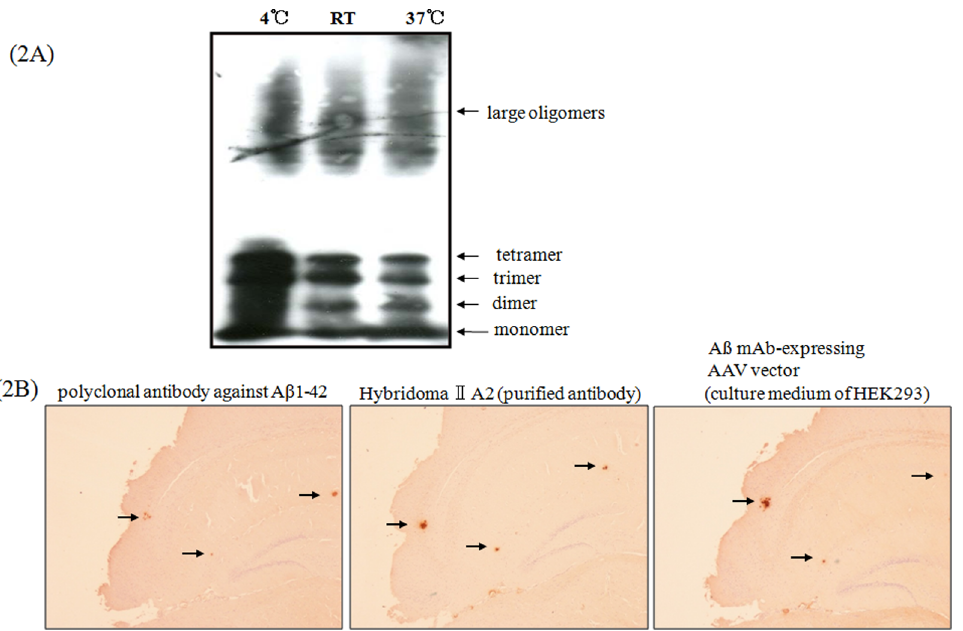
Figure 2. Binding activity of the Ab produced by Aß mAb – expressing AAV vector-transduced cells. A) Binding of Ab from Aß mAb – expressing AAV vector transduced HEK293 cells to synthetic Aß peptides, monomers and oligomers by Western blot. The Ab1-42 peptide was aggregated at 4 u C, room temperature (R.T.), or 37 u C as described in Materials and Methods and detected by culture supernatant derived from Aß mAb – expressing AAV vector transduced HEK293 cells. B) Anti – Aß Ab derived from transduced HEK293 bound to Aß plaques in 16-month old Tg2576 mice. The specificity of this binding was confirmed by use of polyclonal and monoclonal Abs (see details in Materials and Methods).